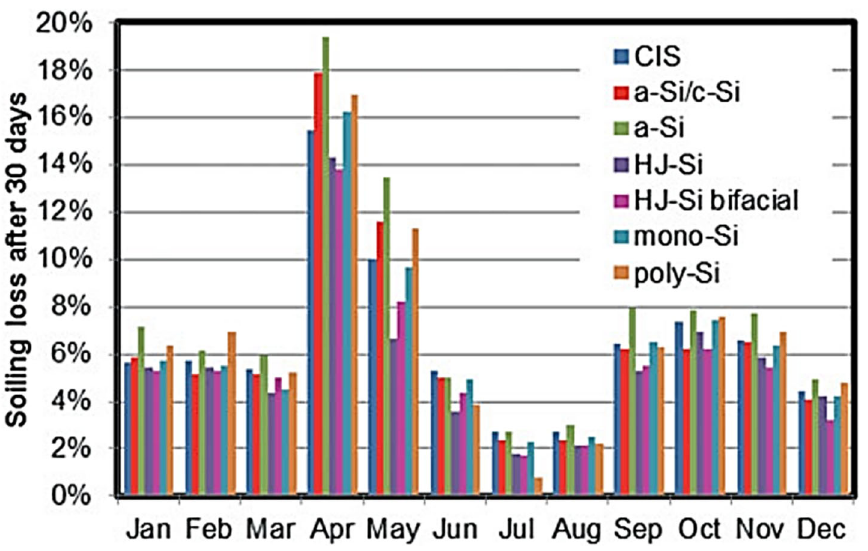
Figure 10. The Soiling loss of different PV technologies after 30-day exposure shows a strong seasonal dependence [60].